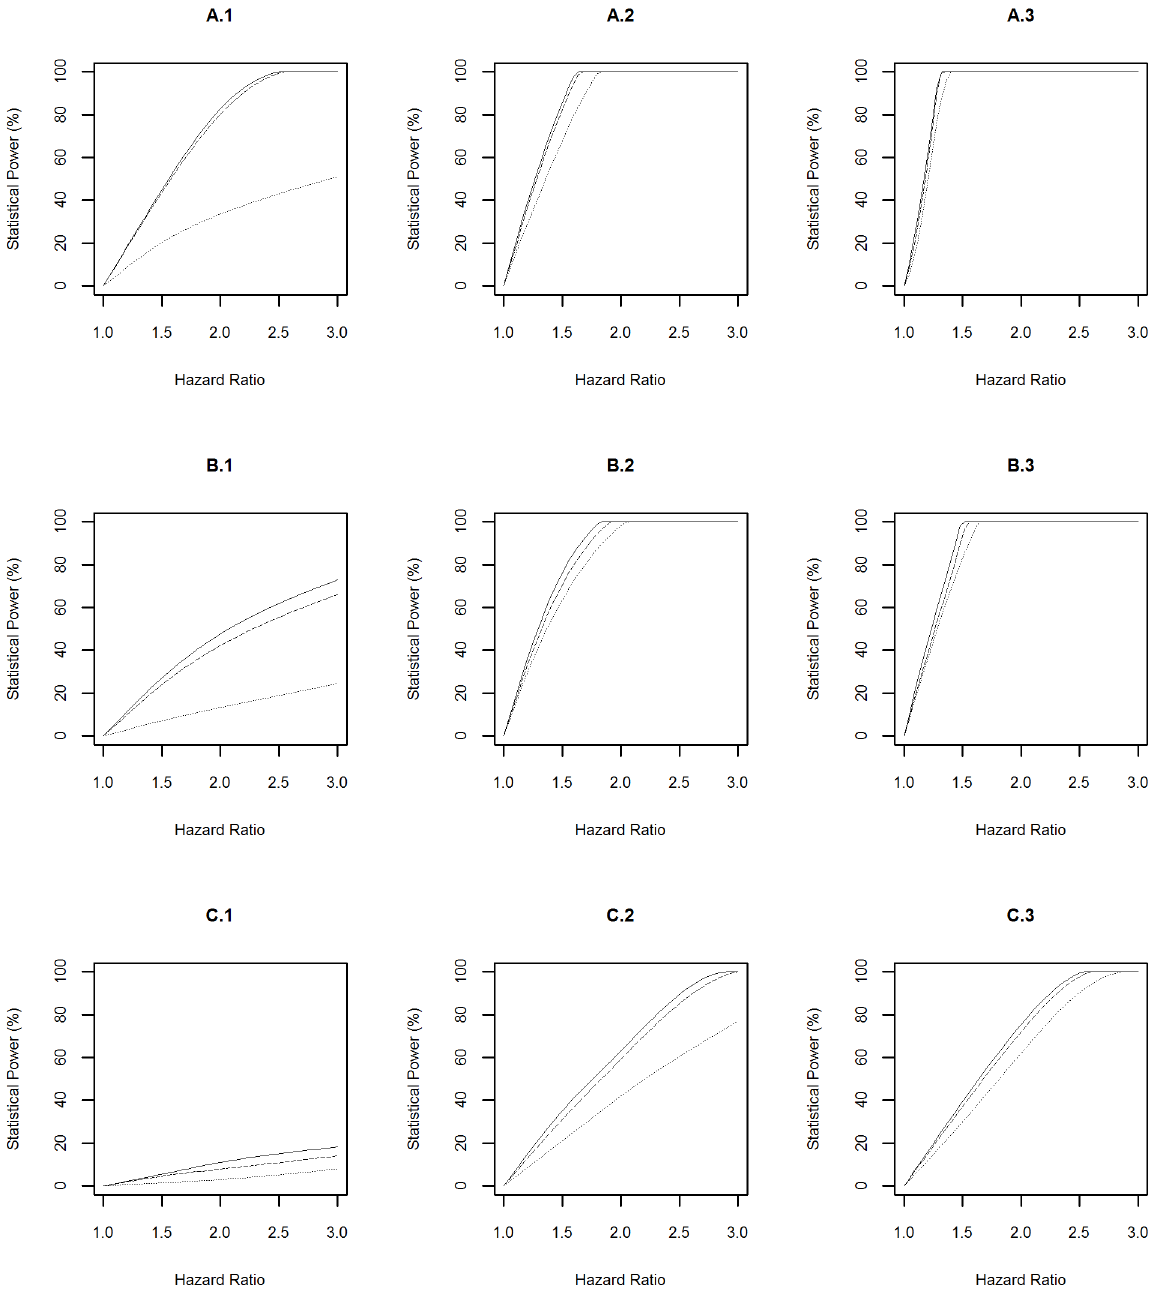
Fig 3. Power Profile at Significance Level of 0.0001 for Genetic Risk Exposure. “ A ” , “ B ” and “ C ” represent diabetes, dementia and Parkinson ’ s disease respectively. “ 1 ” , “ 2 ” and “ 3 ” represent rare (prevalence = 0.01), common (prevalence = 0.1), and very common (prevalence = 0.2) genetic risk factors respectively. The solid, dashed and dotted lines represent the statistical power profile of the study assuming subjects undergo health monitoring continuously, subjects undergo repeated measures every three years, and subjects undergo repeated measures every three years and the genetic risk exposure is measured with a misclassification rate of 0.1